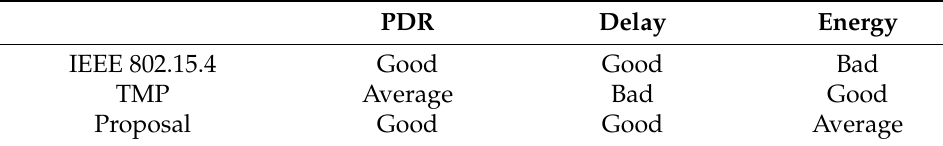
Table 5. Summary of results.